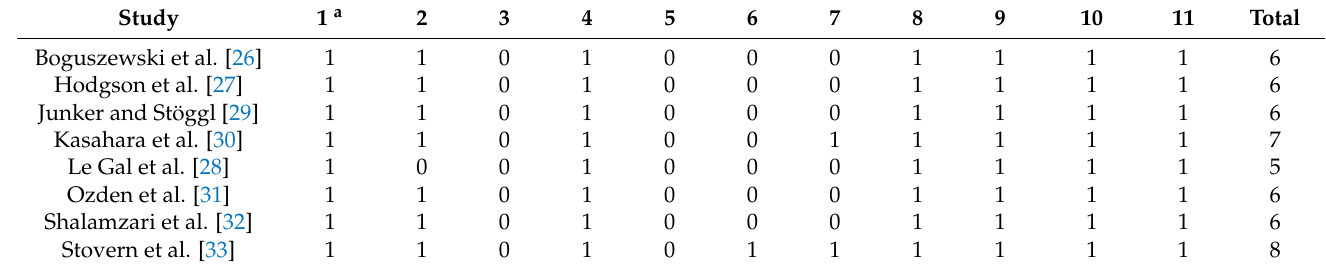
Table 3. PEDro scale of the included studies; a = was not counted for the final score; 1 = one point awarded; 0 = no point awarded. 1. Eligibility criteria were specified. 2. Subjects were randomly allocated to groups (in a crossover study, subjects were randomly allocated an order in which treatments were received). 3. Allocation was concealed. 4. The groups were similar at baseline regarding the most important prognostic indicators. 5. There was blinding of all subjects. 6. There was blinding of all therapists/researchers who administered the therapy/protocol. 7. There was blinding of all assessors who measured at least one key outcome. 8. Measures of at least one key outcome were obtained from more than 85% of the subjects initially allocated to groups. 9. All subjects for whom outcome measures were available received the treatment or control condition as allocated or, where this was not the case, data for at least one key outcome were analyzed by “intention to treat”. 10. The results of between-group statistical comparisons were reported for at least one key outcome. 11. The study provided both point measures and measures of variability for at least one key outcome.